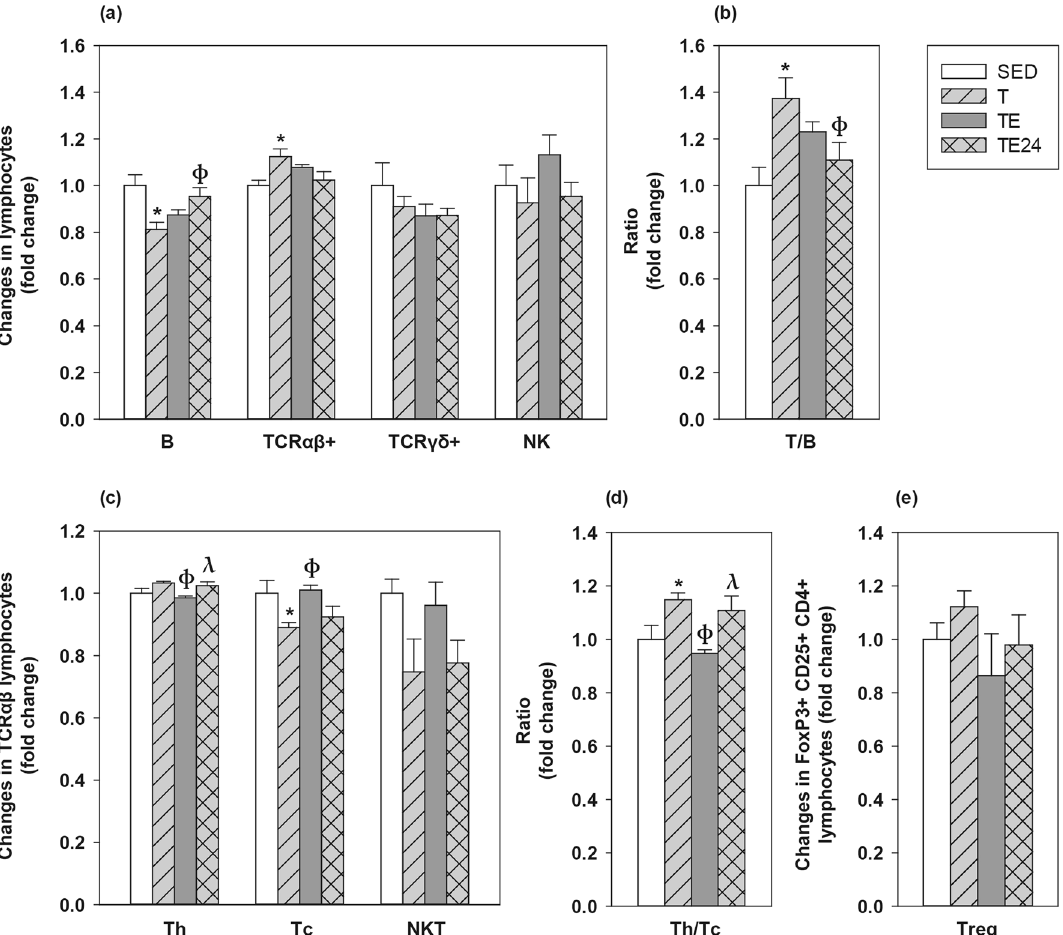
Figure 5. Changes in the proportion of mesenteric lymph node lymphocytes compared to the sedentary group. Main lymphocyte subsets ( a ); Tαβ/B lymphocytes ratio ( b ); main Tαβ subsets ( c ); Th/Tc ratio ( d ) and Treg proportion ( e ). SED sedentary rats, T trained rats, TE T rats with an additional final exhaustion test, TE24 TE rats 24 h after the additional final exhaustion test. Data are expressed as mean ± SEM (n = 8). Statistical